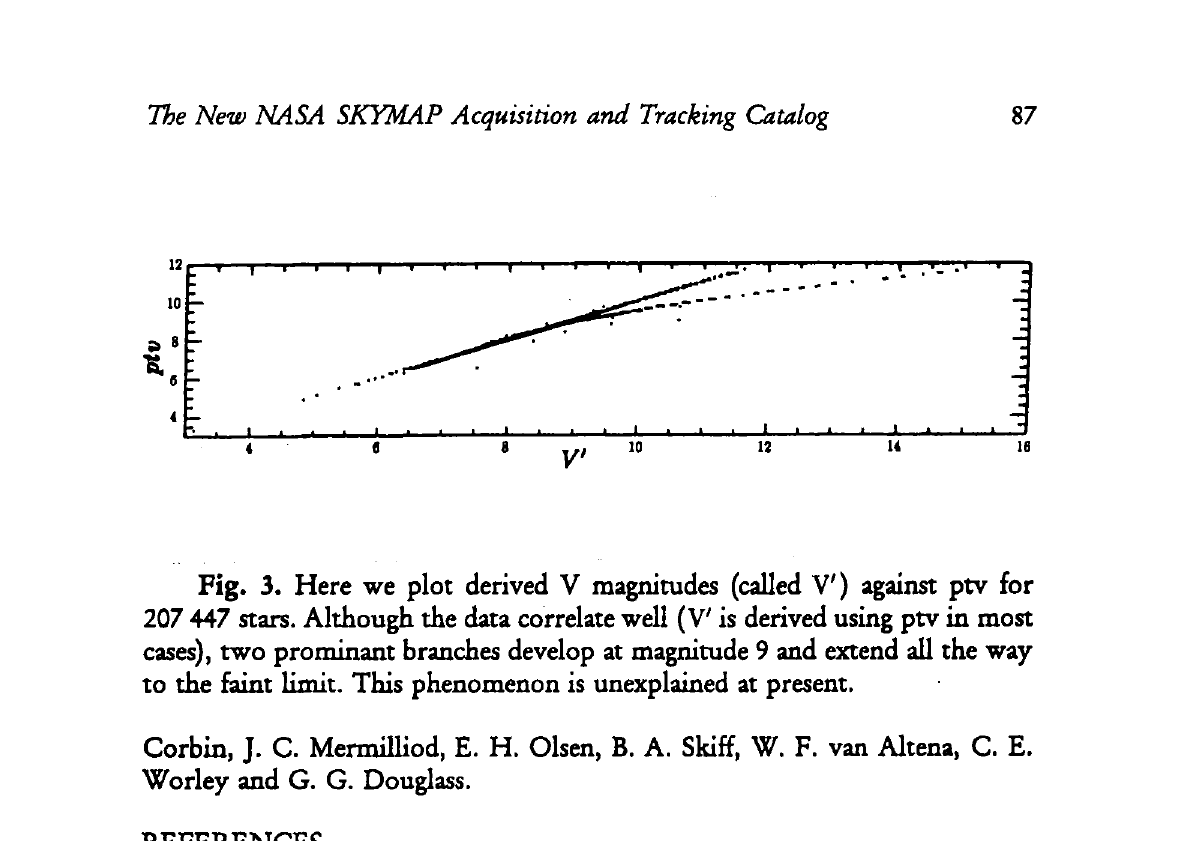
Fig. 3. Here we plot derived V magnitudes (called V') against ptv for 207 447 stars. Although the data correlate well (V' is derived using ptv in most cases), two prominant branches develop at magnitude 9 and extend all the way to the faint limit. This phenomenon is unexplained at